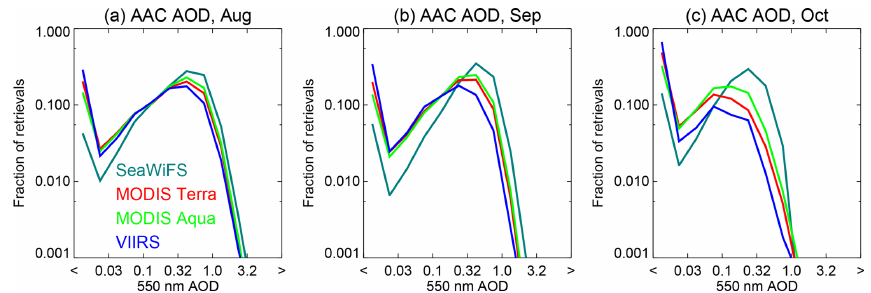
Figure 14. Histograms of AAC 550nm AOD retrieved over the green box (25 ◦ S–0 ◦ N, 15 ◦ W–15 ◦ E) in Fig. 2, aggregated from level 2 retrievals over the full satellite records processed during the ORACLES campaign season. Panels show data for August, September, and October. Throughout, SeaWiFS data are shown in teal, MODIS Terra in red, MODIS Aqua in green, and VIIRS in